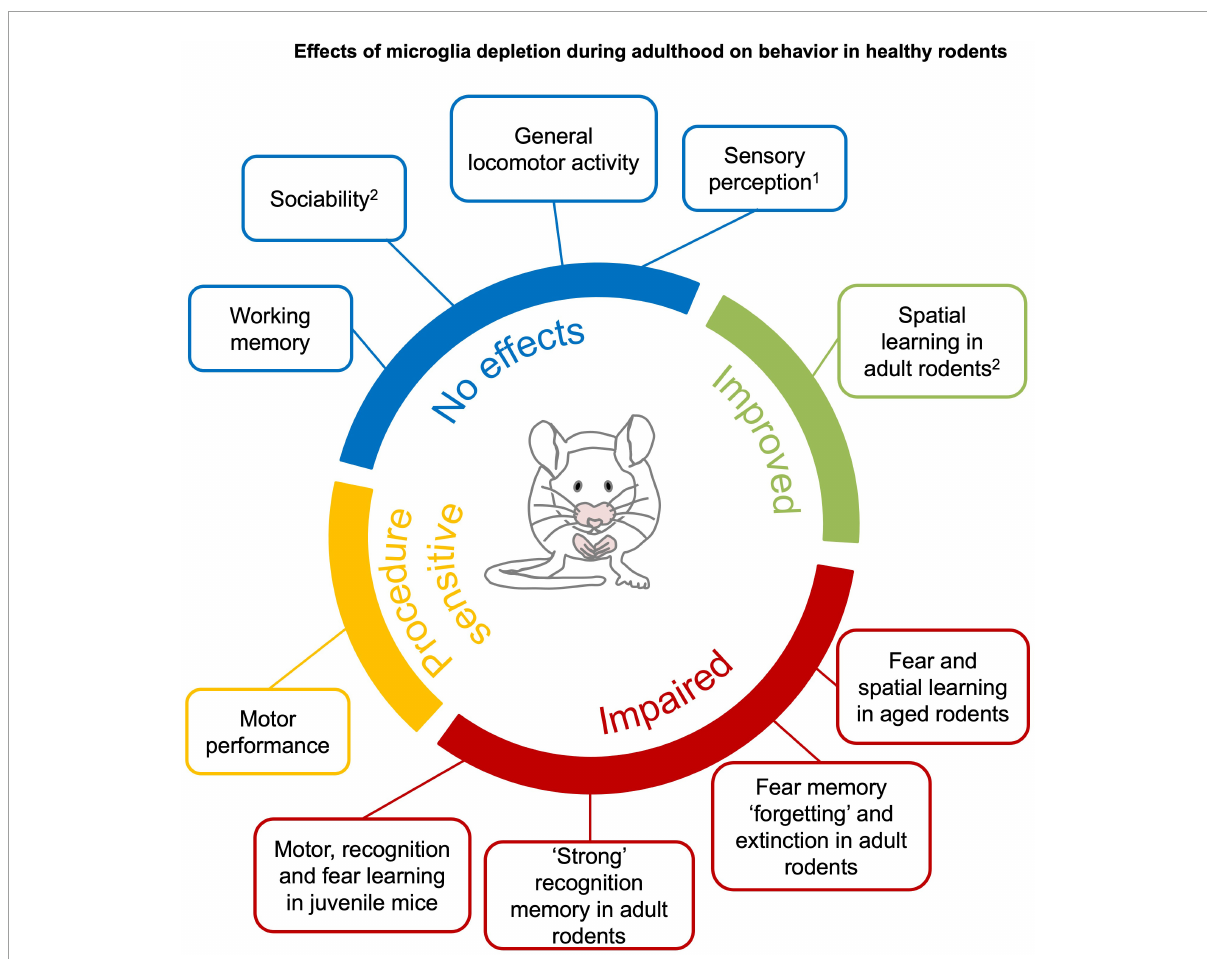
FIGURE3 Effects of microglia depletion during adulthood on behavior in healthy rodents. Microglia depletion in the healthy adult brain does not have major effects on sensory perception 1 , general locomotor activity, anxiety, sociability and working memory ( blue ). Motor function is impaired after genetic DT-induced microglia depletion (Parkhurst et al., 2014; Rubino et al., 2018), but not pharmacological depletion ( yellow ). Complex recognition memory and specific learning processes, such as “forgetting” and extinction of fear memories, are compromised in young mice with microglia depletion. Learning deficits are observed when microglia are depleted in juvenile or aged mice ( red ). Spatial learning is improved in young mice ( green ). 1 An exception is reported by Rubino et al. (2018) that found altered gustatory perception in genetic DT-induced